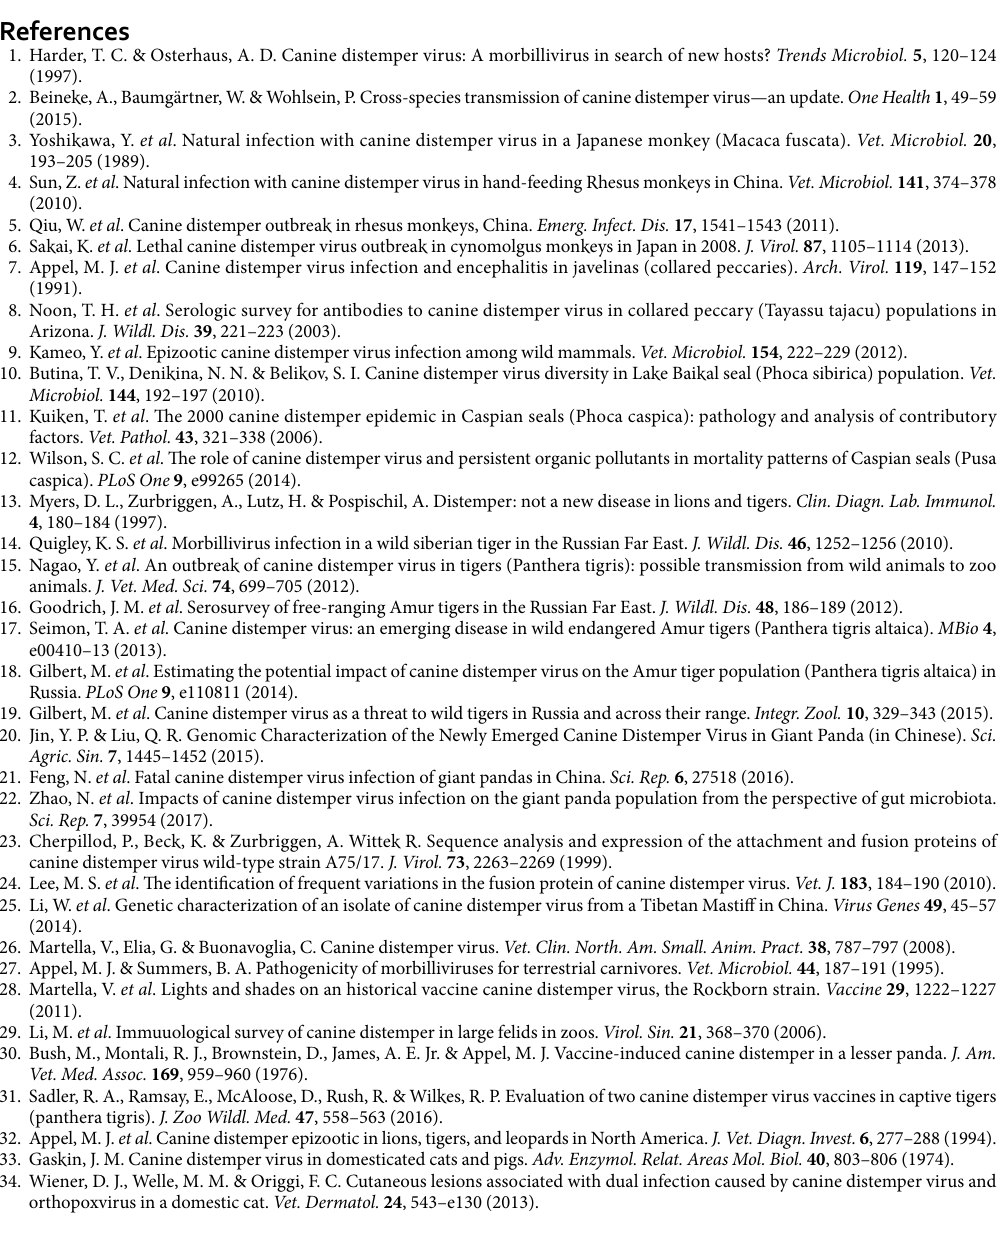
implemented in MEGA 5.1 software. Moreover, the N-glycosylation sites of H protein were analyzed with NetNGlyc 1.0 Server (http://www.cbs.dtu.dk/services/NetNGlyc/). The threshold value was set at 0.32. Structure prediction of H and F proteins. To master the advanced structure feature of H and F protein, online prediction program (Swiss-Model) was used (https://swissmodel.expasy.org/interactive). Their structure was displayed using the CPK style in a molecule window (Discovery Studio 4.5 software).